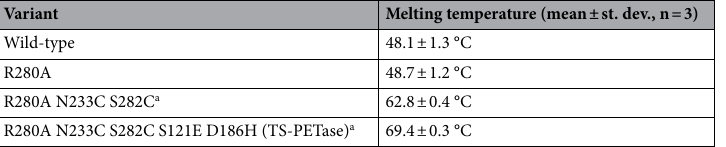
Table 1. Denaturation temperatures of Is PETase mutants. a Novel variants generated in this study.